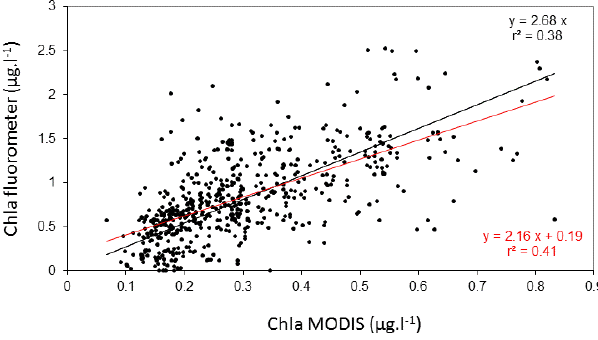
Figure 9. Relationship between the o ff set, quenching corrected HPLC inter-calibrated fluorometers with the corresponding 9km weekly MODIS data. Both regressions with (in red) and without (in black) intercept are